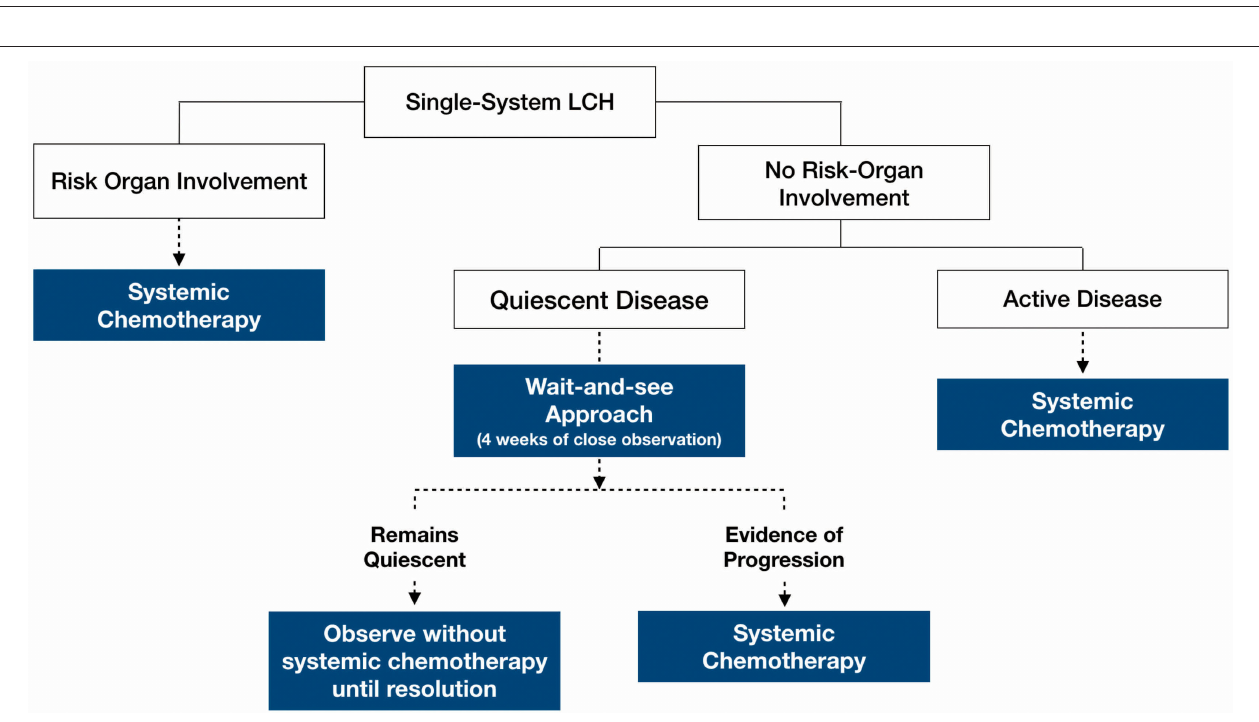
FIGURE 3 | Proposed clinical decision-making framework.